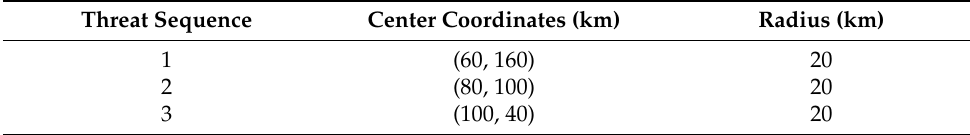
Table 11. Parameter settings of the threat